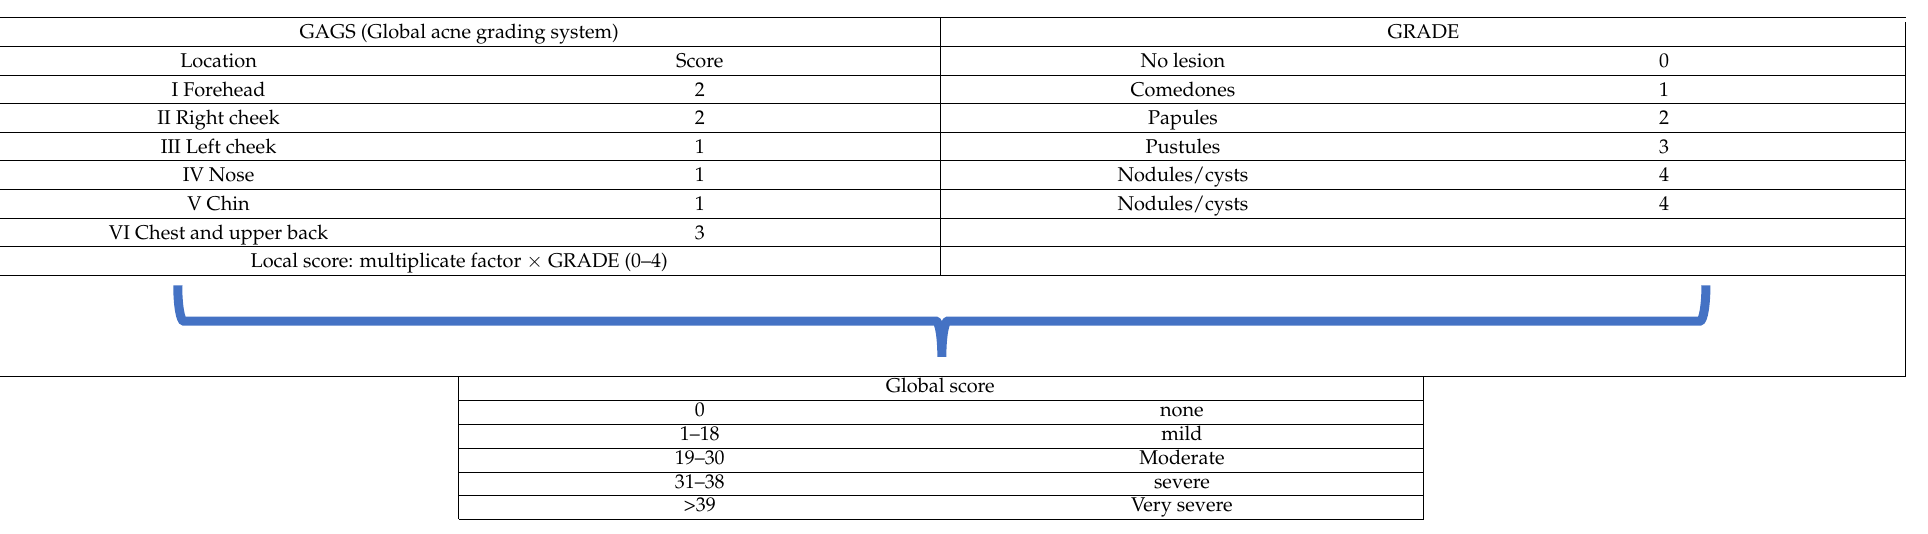
Table 2. The GAGS: Global Acne Grading System explanation [47].